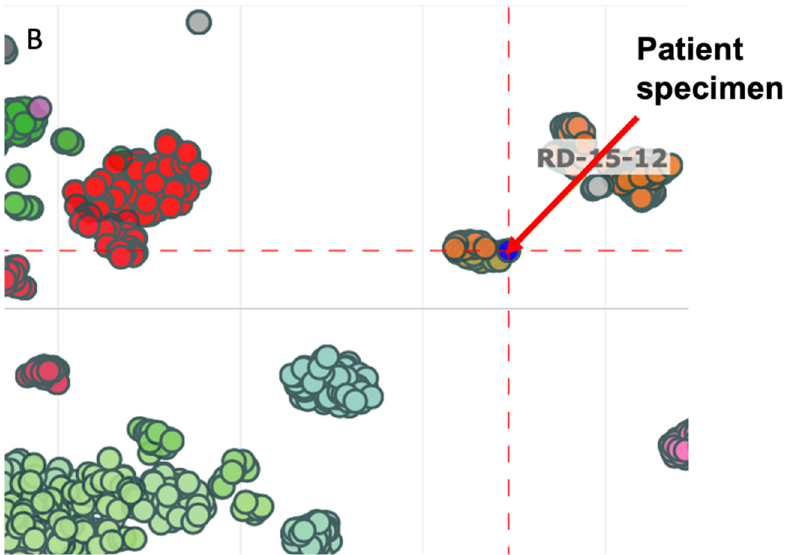
Figure 2. ( A ) TSNE clustering of reference cohort methylation profiles in relation to the patient’s specimen. TSNE clustering is a method for visualizing high-dimensional data in a two-dimensional map. Each point represents a specimen’s methylation profile. The blue point indicated by the red arrow corresponds to our patient’s specimen. All other points correspond to cases in the classifier’s reference cohort. Each tumor class is assigned a color-code. The blue circle encompasses the cluster of reference esthesioneuroblastomas. ( B ) Zoomed-in TSNE clustering to better illustrate ENB subgroups A and B relative to the patient’s specimen. The blue point indicated by the red arrow corresponds to our patient’s specimen. The surrounding tan and orange data points correspond to reference esthesioneuroblastomas of subgroup A and B respectively.